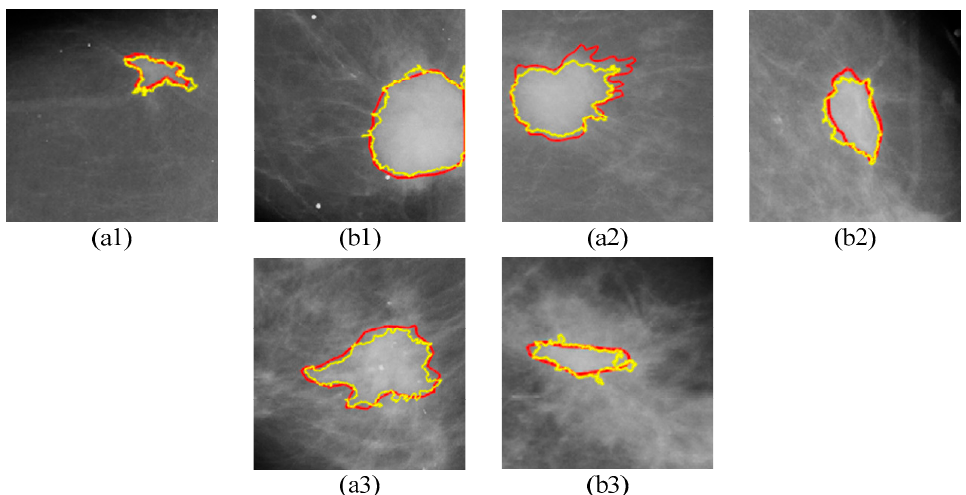
Figure 10. Detection results of images of different density rating: ( a1 ) B_3022_1.RIGHT_CC; ( b1 )